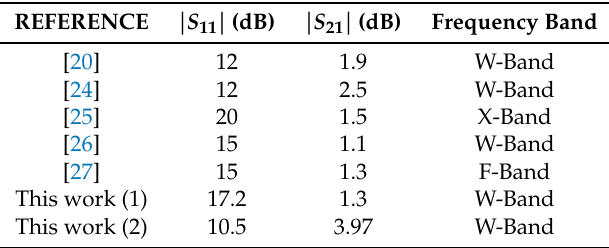
Table 4. Performance of millimeter wave rectangular waveguide to microstrip